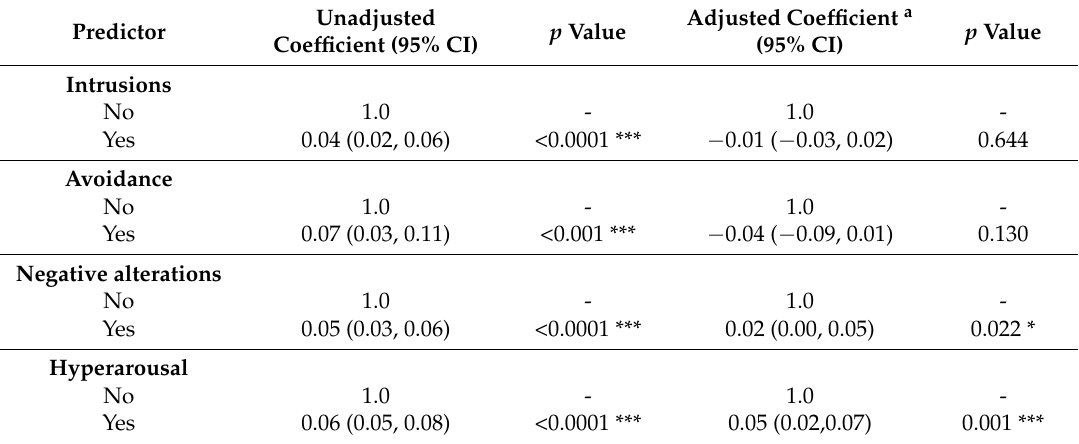
Table 4. Association between PTSD symptom clusters and risk-taking behavior.